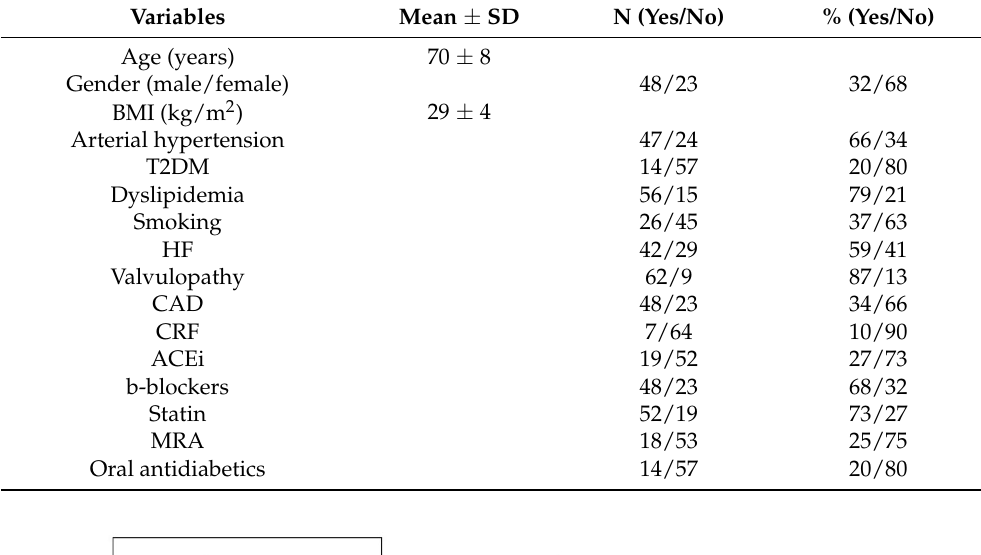
Table 2. Clinical characteristics of all patients for biopsies.